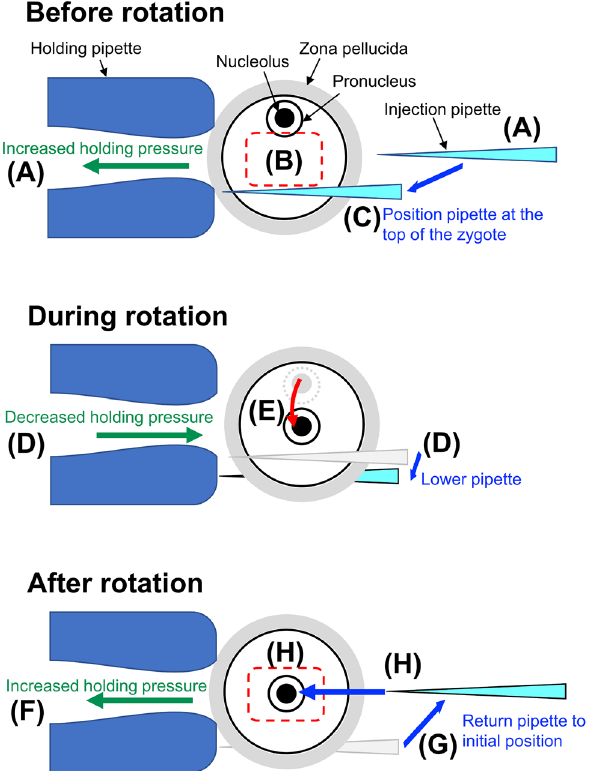
Figure 3. Procedure to fully rotate the zygote to move the pronucleus to the injection pipette insertion position. ( A ) Before rotation, the zygote is held in the holding pipette under a state of increased holding pressure. The injection pipette is held stationary at the middle height position of the zygote. ( B ) If the pronucleus inside the zygote is outside the range (red dotted square) where automated solution injection is possible. ( C ) The injection pipette automatically moves to the upper part of the zygote opposite the pronucleus. ( D ) Due to the decreased holding pressure, the zygote disengages from the holding pipette, and immediately lowering the injection pipette causes the zygote to rotate. ( E ) With the rotation, the pronucleus moves from the corner of the zygote to the center (red arrow). ( F ) Immediately after rotation, the holding pressure is increased to hold the zygote. ( G ) The injection pipette is returned to its initial position ( A ). ( H ) When the pronucleus is within the range for automated solution injection (red dotted square), the injection pipette is inserted into the